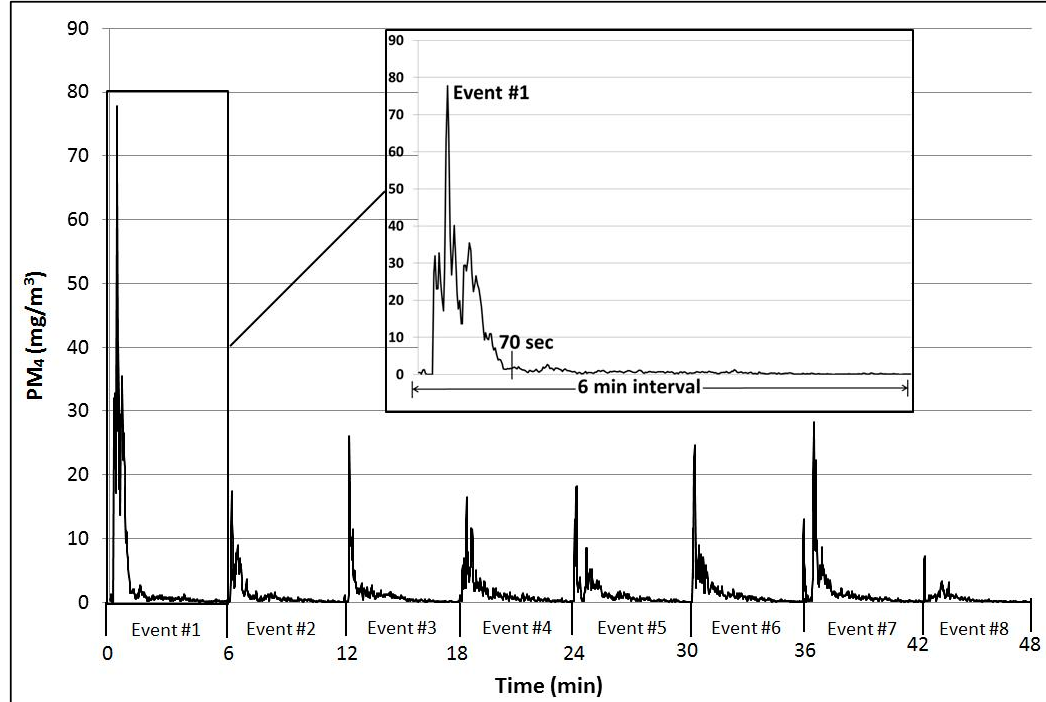
Figure 1. Respirable talc concentrations (PM 4 ) monitored in a laboratory chamber (temp. 26.5–27.0 °C and RH 20–21.2%) during eight application events (at 6 min intervals) over 48 min. Each application event consisted of three squeezes of a talc product bottle (baby powder). Inset shows details of Event 1.